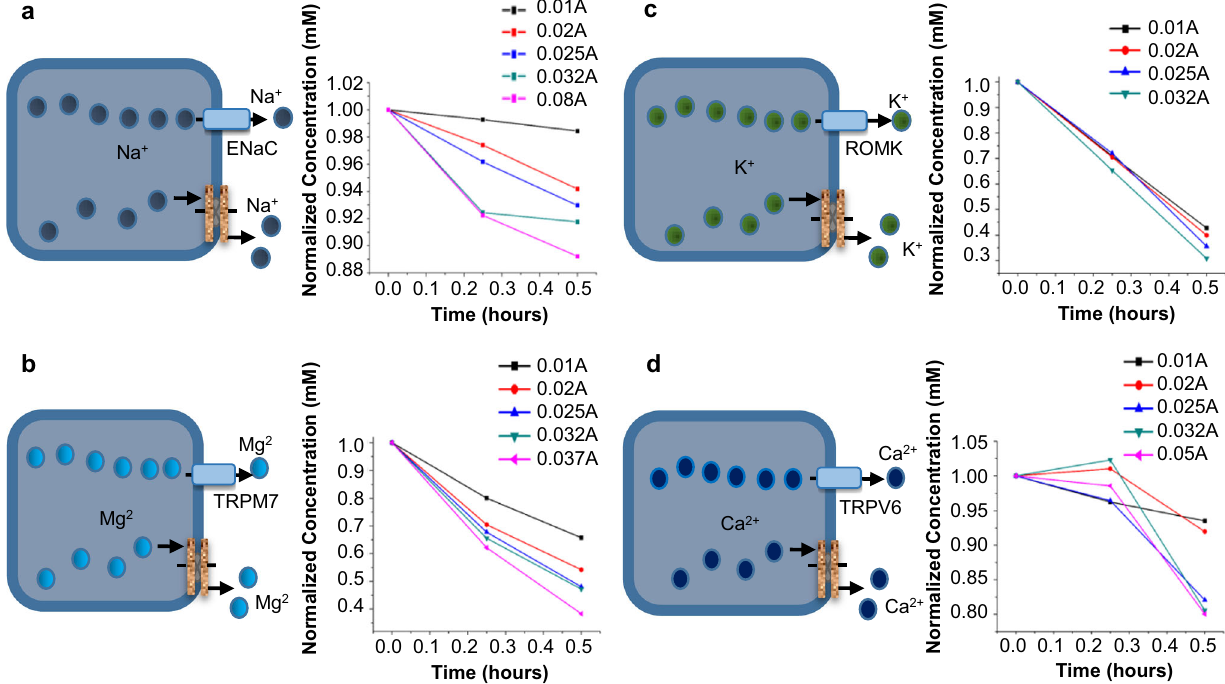
Fig. 2 Nephron ion transport compared to AWEDI. Ion transport processes in the nephron as examples that compare to the ability of AWEDI devices to specially modulate the transport of various ions at different applied currents: a sodium, b potassium, c calcium, and d